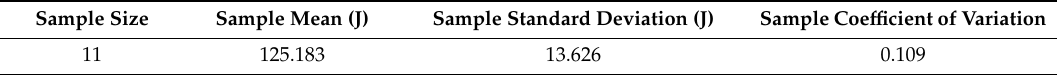
Table 6. Sample statistical data of transferred energy measured by the aluminum honeycomb